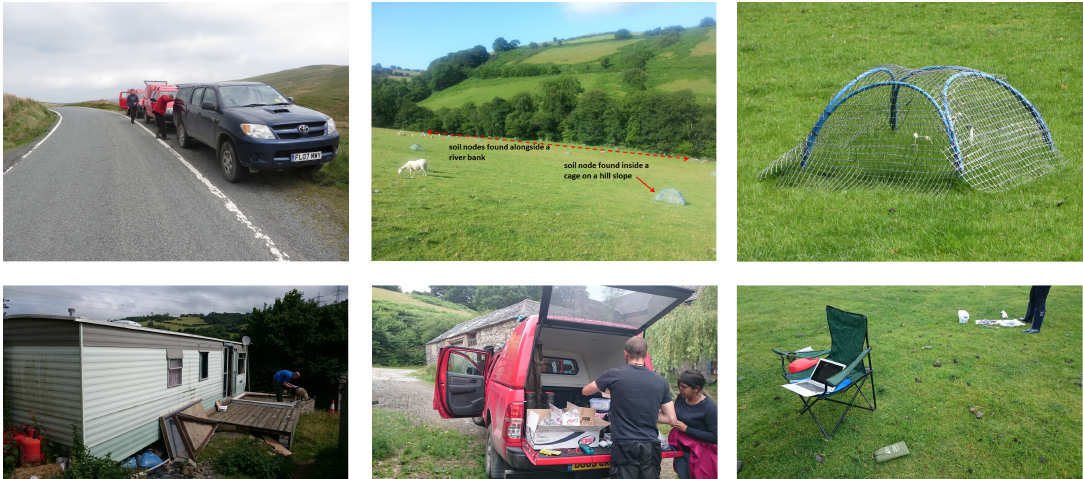
Figure 14. Images from our deployment site. Clockwise from top left: initial site reconnaissance with environmental scientists; the site as we initially found it; a protective dome over a soil sensing node; configuring the relay node; constructing hardware at the site; and the location of the Internet gateway